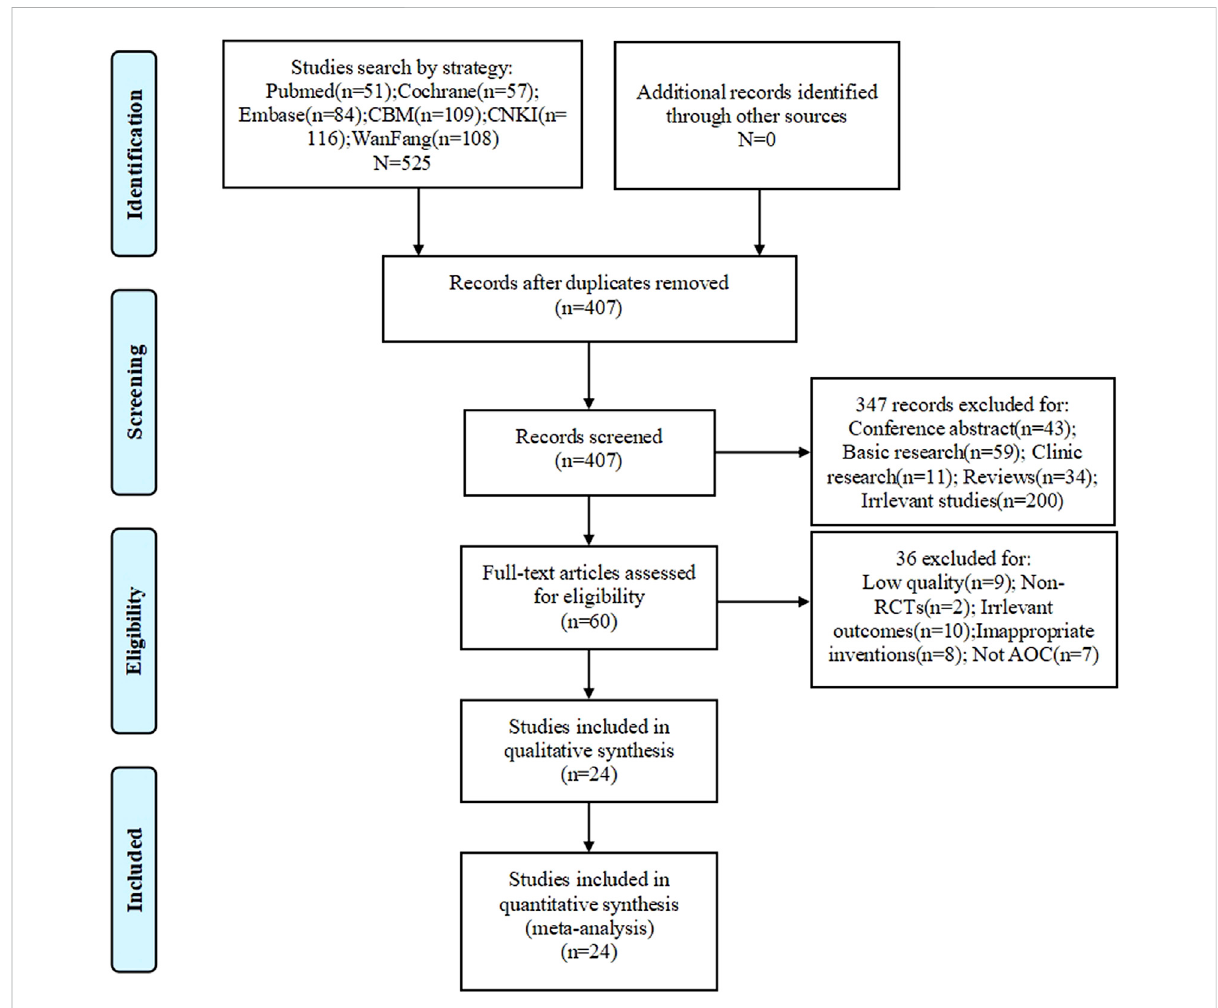
FIGURE 1 PRISMA fl ow diagram of the study selection